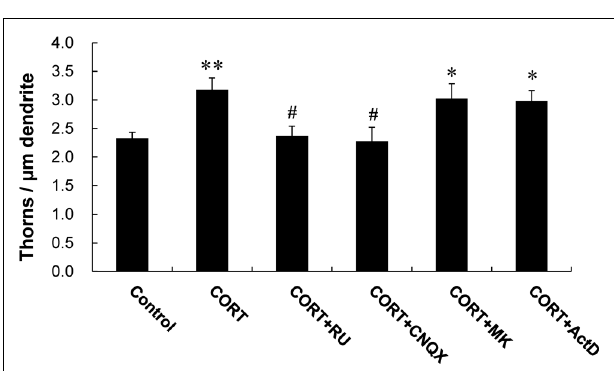
FIGURE 2 |Time dependency and dose dependency of CORT effects on the thorn density of CA3 neurons. Thorns were analyzed along the primary and secondary dendrites of pyramidal neurons in the stratum lucidum of CA3 neurons. (A) The time dependency of CORT effects on the thorn density in CA3 neurons, after 0.5 h treatment (0.5 h), 1 h treatment (1 h), and 2 h treatment (2 h) in ACSF with 1 μ M CORT. As a control, no treatment with CORT (0 h) is shown. (B) Dose dependency of CORT treatments on the thorn density. A 1 h treatment in ACSF without CORT (0 nM), with 10 nM CORT